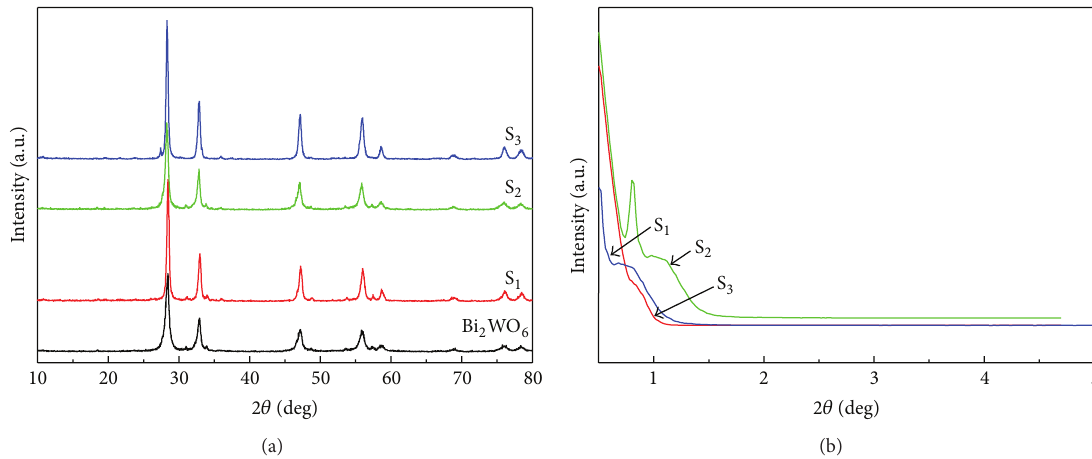
Figure 1: (a) WXRD patterns of Bi 2 WO 6 , S 1 S 2 , and S 3 and (b) LXRD patterns of S 1 , S 2 , and S 3